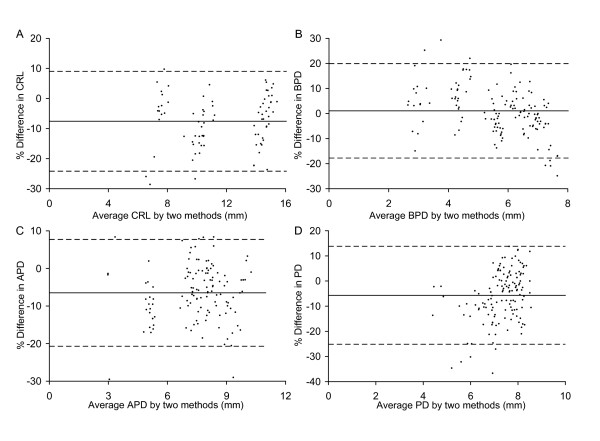
Statistical evaluation of ultrasound versus light microscopy measurements. Bland-Altman analyses of the relationship between measurements obtained by ultrasound (UBM) in vivo and by light microscopy (LMM) ex vivo for (A) crown-rump length (CRL), (B) biparietal diameter (BPD), (C) anterioposterior abdominal dimension (APD), and (D) placental diameter (PD). The difference between paired measurements are plotted against the mean of the two measurements. Each point shows the paired results obtained in one conceptus. The solid line in each graph shows the bias between the two measurement methods. The bias was not significantly different from zero for all four variables. The dashed lines show the ± 95% confidence intervals.